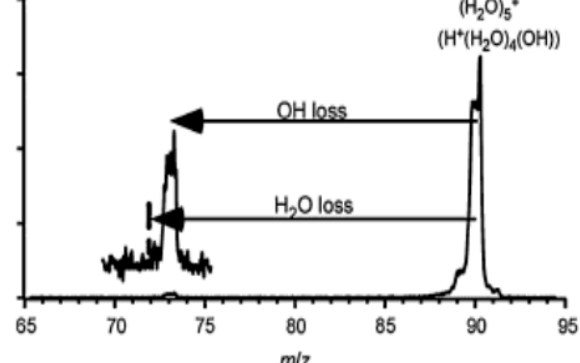
Figure 16. Infrared photodissociation mass spectrum of (H 2 O) 5 + • . Figure adapted from [15] with permission. Copyright 2011 The Royal Society of